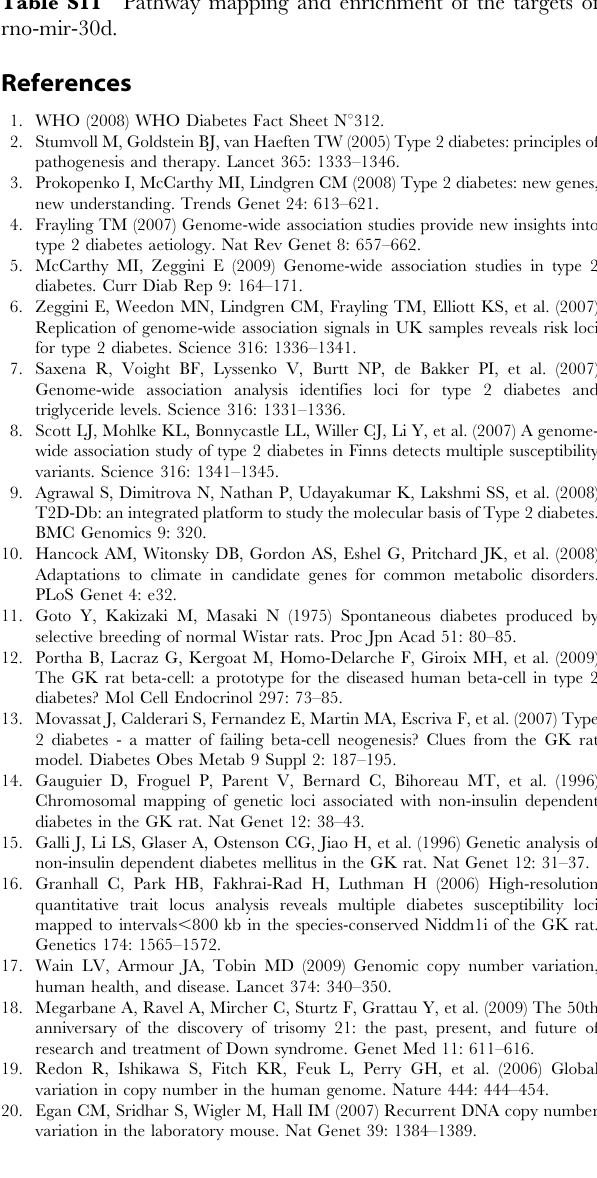
Table S8 Preferentially selected protein-coding genes in GK/ Wistar CNVRs.